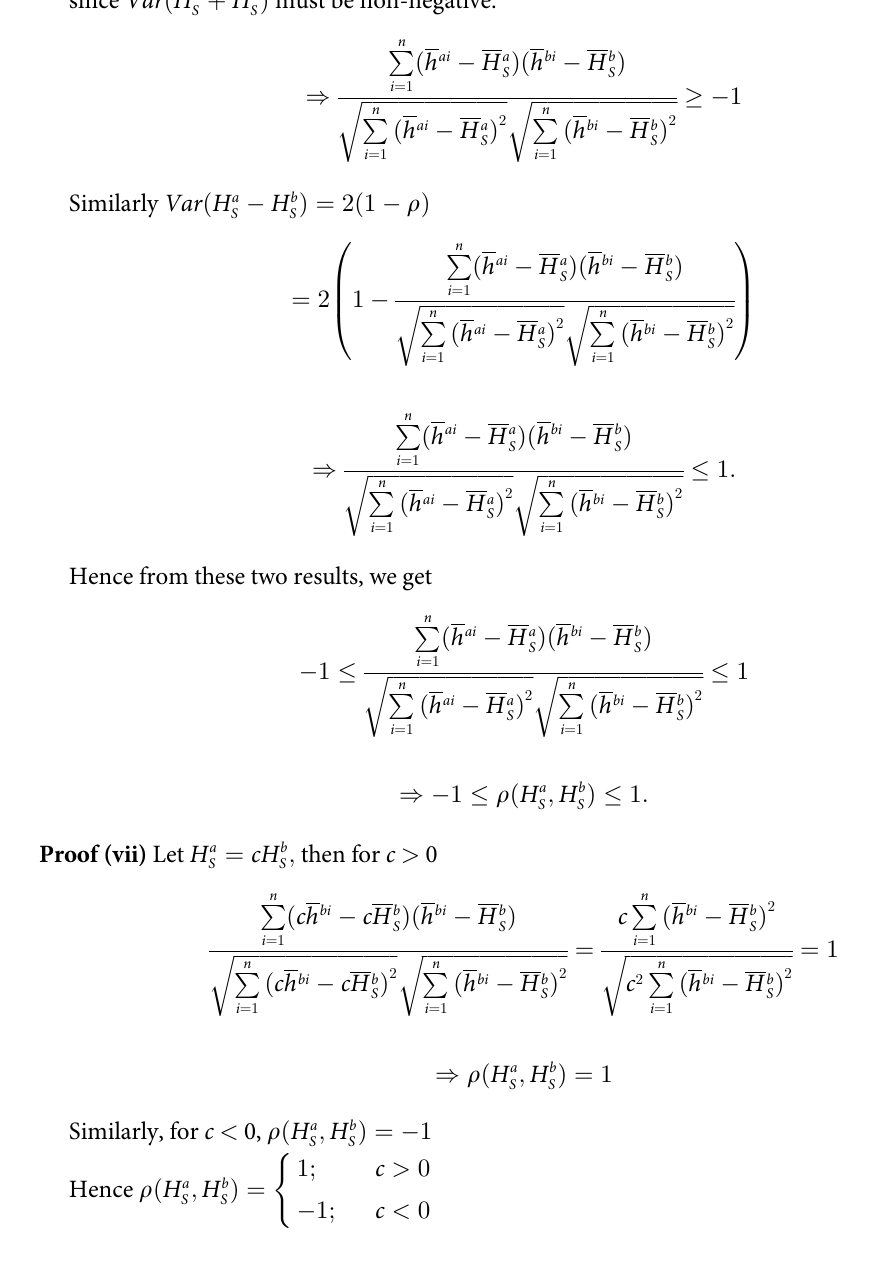
ffiffiffiffiffiffiffiffiffiffiffiffiffiffiffiffiffiffiffiffiffiffiffiffiffiffiffiffi P n